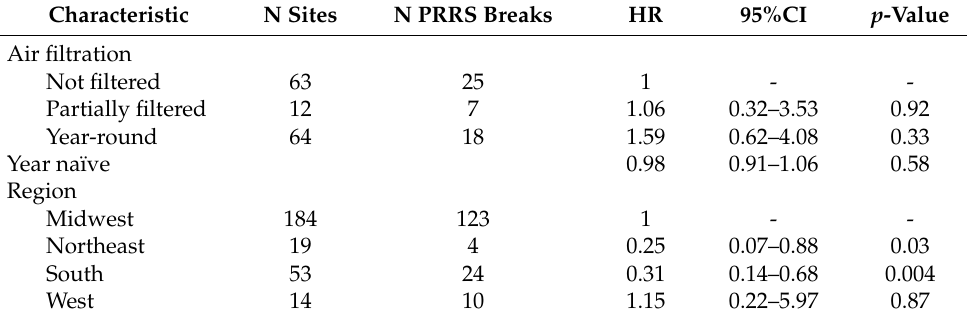
Table 1. Bivariate multilevel mixed-effects parametric survival models with sites nested within the production system as a random effect showing hazard ratio (HR) of PRRS outbreaks in sites that reached a naïve status from July 2009 to October